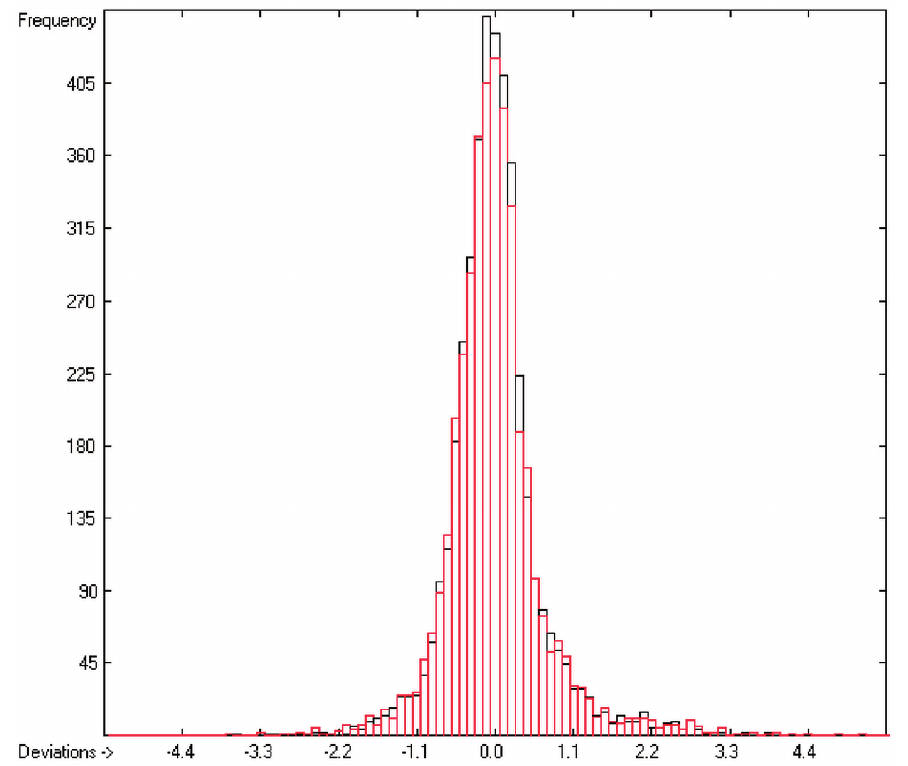
Figure 10. Correlation diagram of refractivity data (10-fold cross-validated: N = 4039, Q 2 = 0.9988, slope = 1.0).